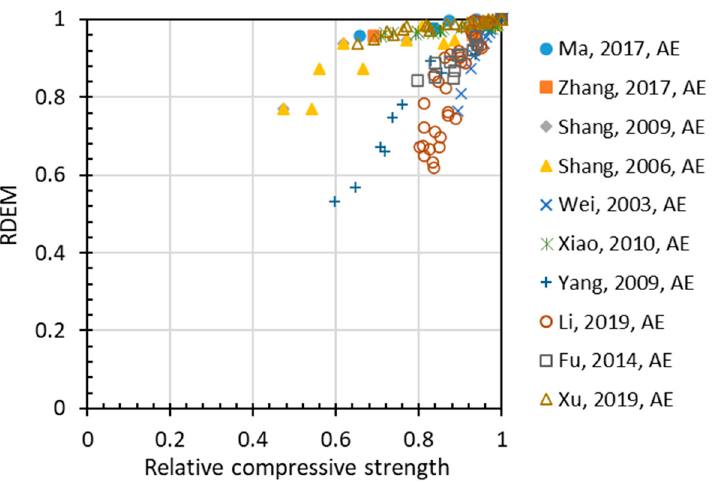
Figure 8. Relation between RDEM and relative compressive strength for air-entrained concrete.